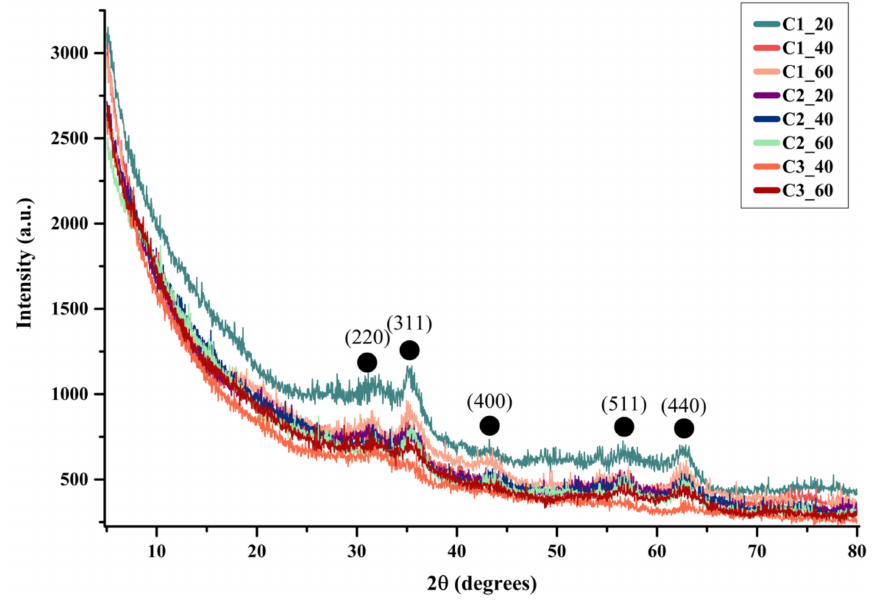
Figure 4. Diffractograms for the MNPs samples ( • —Fe 3 O 4 ).